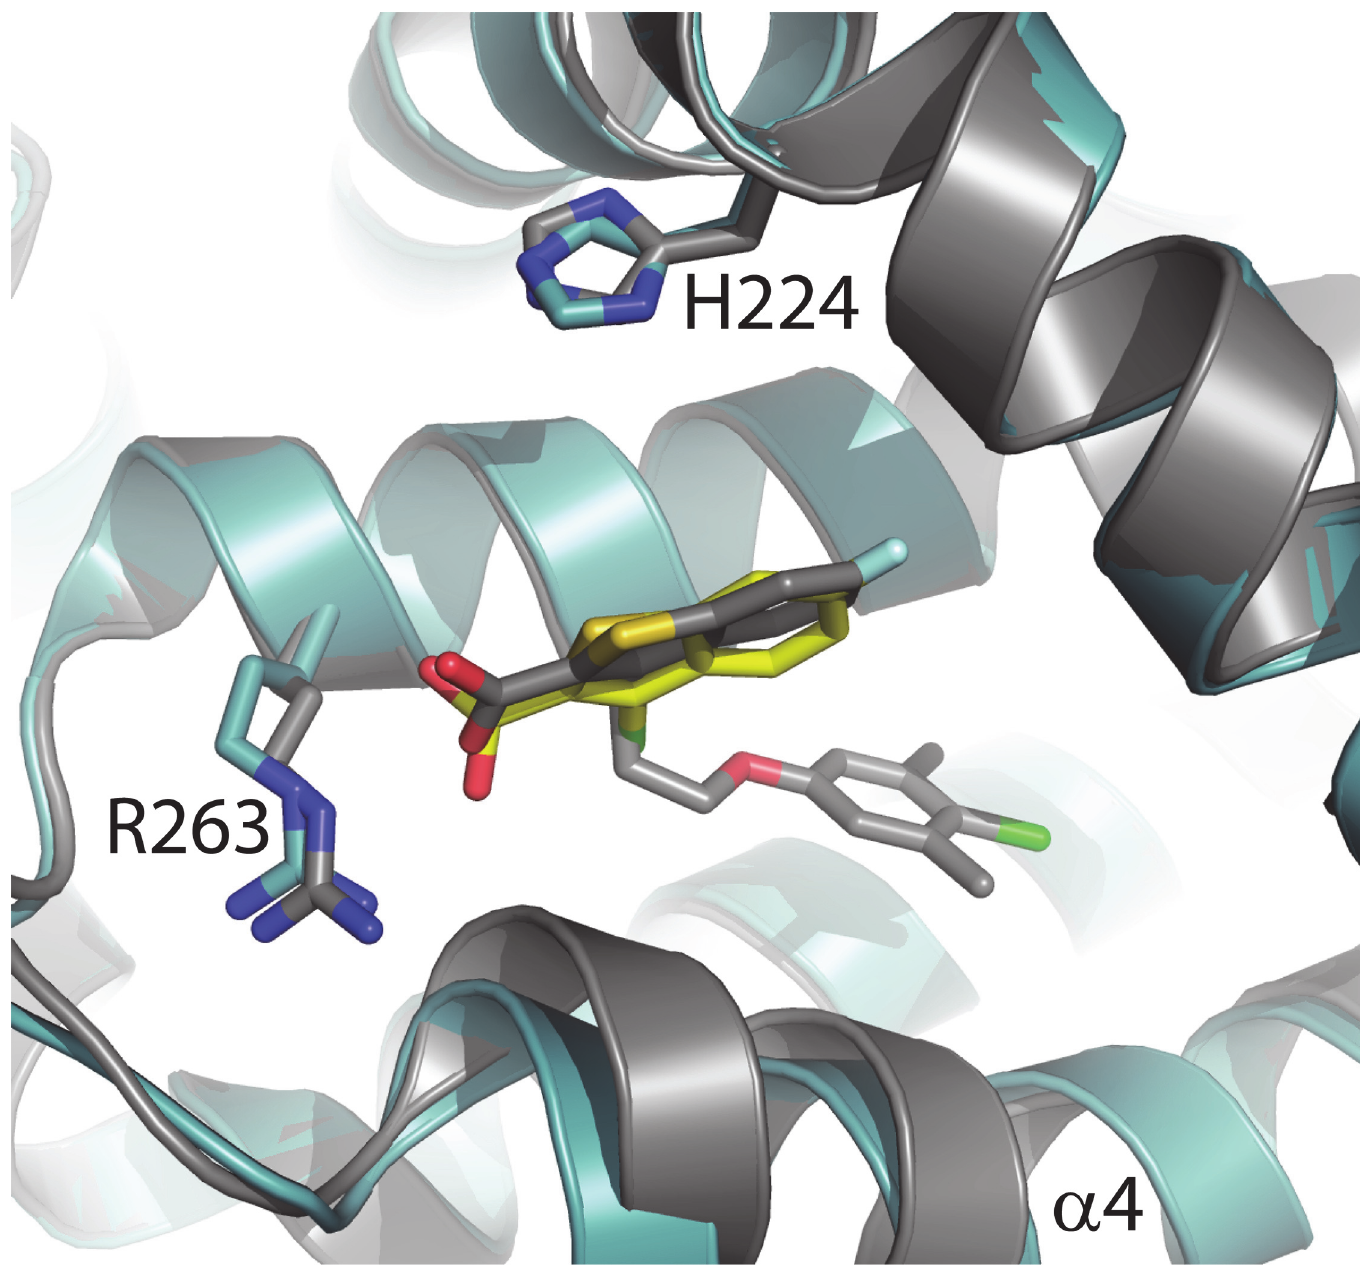
Fig 6. Comparison of PDB 4HW3 and MBP-MCL1 with fragment 4. The structure of MBP-MCL1 with fragment 4 (yellow) determined to 2.4 Å (blue) overlaid with the structure of MCL1 171 – 323 determined at 2.4 Å (PDB ID 4HW3, gray). The carboxylic acid of 4HW3 adopts multiple conformations depending on the chain; only chain A is shown for